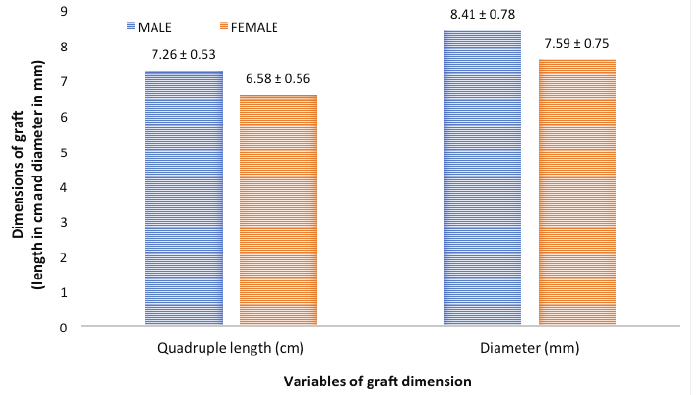
Mean GL is significant higher in male compare to female (t value=5.88, Z score=4.98, p value<0.00001). Similarly for GD (t Fig. 1: value=4.93, Z score= 4.45, p value<0.00001) male had significant higher value compared to female.